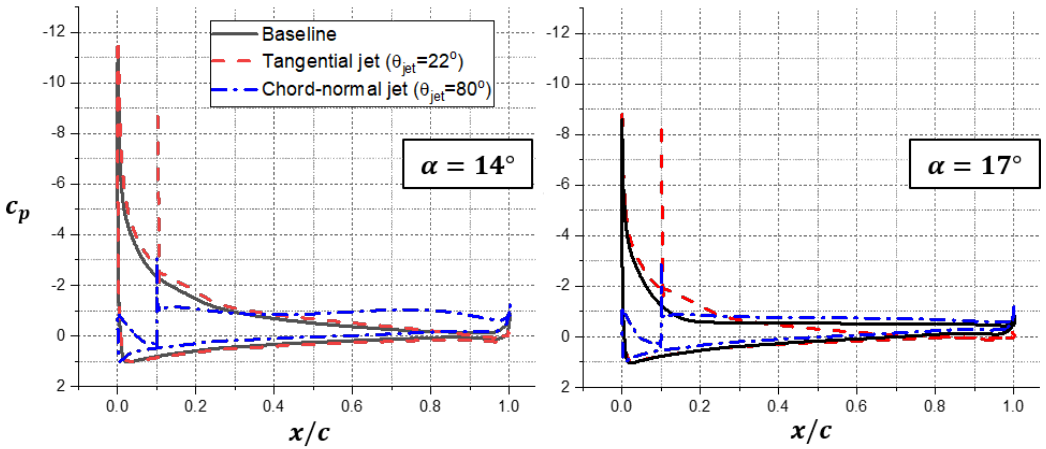
Figure 11. Comparison between static OA209 with and without steady-blowing jets. Ma = 0.3, Re = 1.15 M, c µ = 0.06 at α = 14 ◦ ( left ) and 17 ◦ ( right